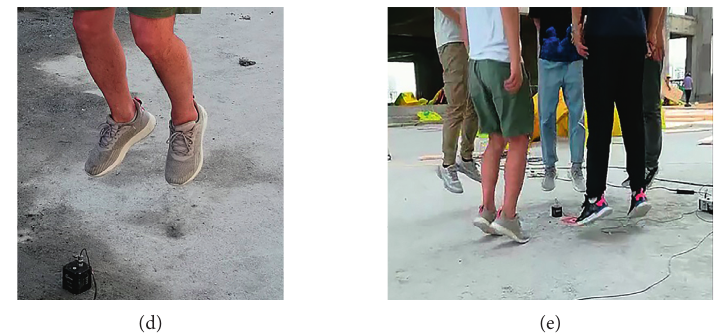
Figure 6: Human-induced vibration tests: (a) measurement locations; (b) single-person heel-drop tests; (c) five-persons heel-drop tests; (d) single-person jumping tests; and (e) five-persons jumping tests.